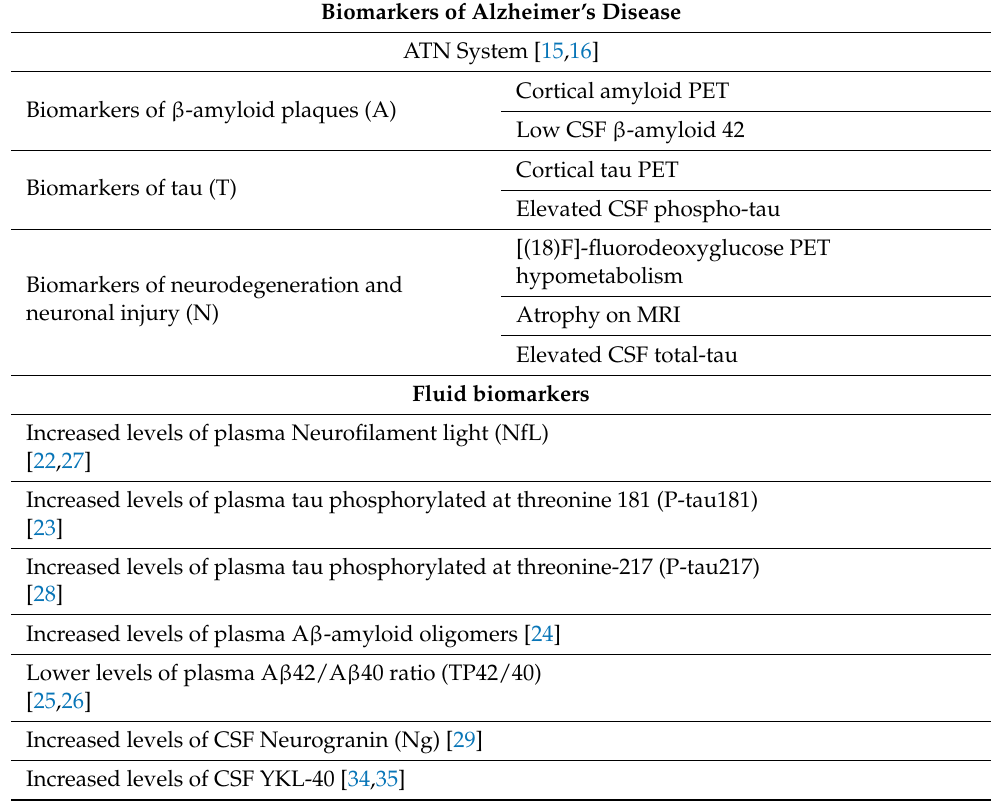
Table 2. Biomarkers of Alzheimer’s